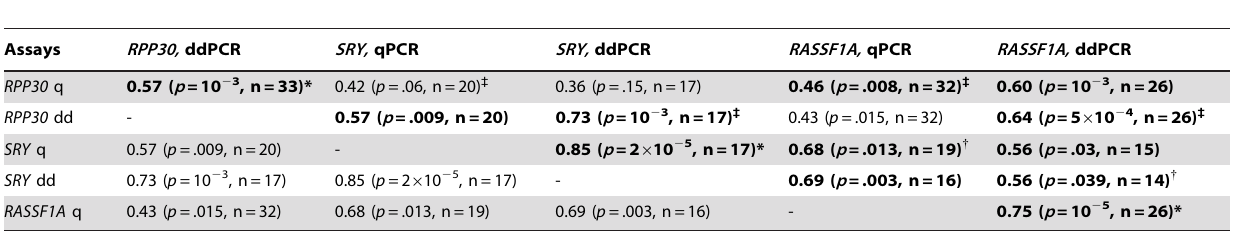
Table 1. Correlation (Pearson’s) between different DNA concentration values for RPP30 , SRY and RASSF1A assays using qPCR and ddPCR techniques.